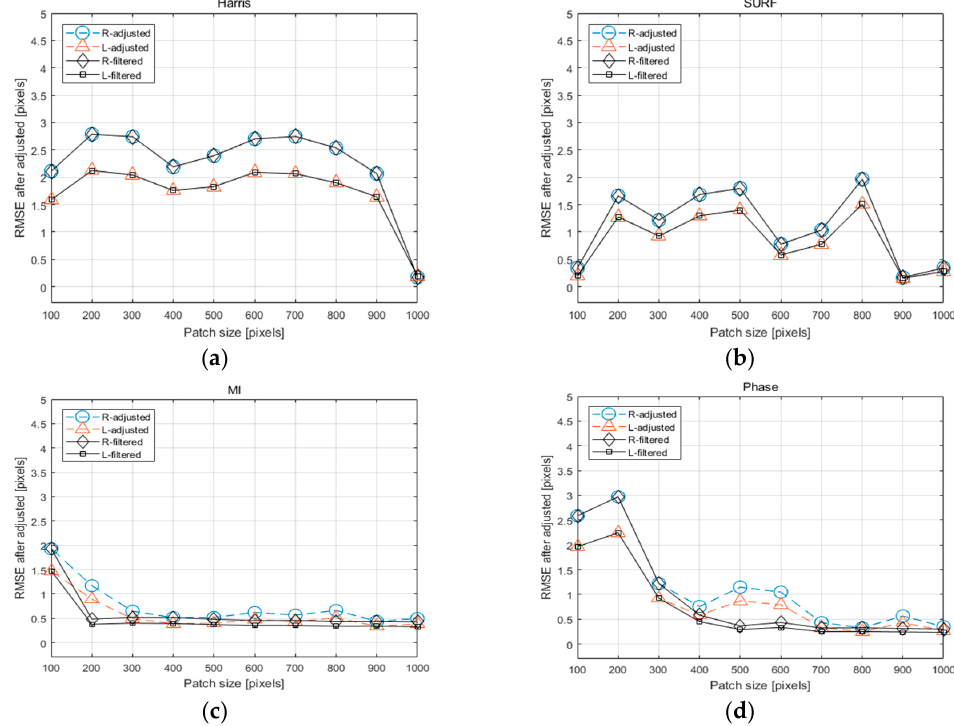
Figure 21. Reprojection errors (across-track Kompsat-3A coarse epipolar—after adjustment): ( a ) HARRIS–FREAK ( b ) SURF, ( c ) MI, and ( d )